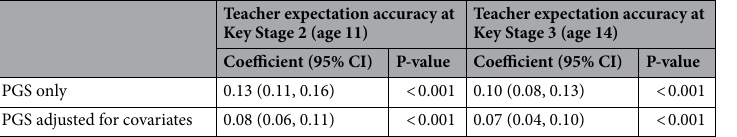
Table 3. Associations between teacher expectation and pupil’s polygenic scores (PGS). Positive values reflect pupils who overperformed relative to their teacher’s expectations, while negative values reflect pupils who underperformed relative to their teacher’s expectations. n = 7465. Full results in Supplementary Table S2. Results for complete case analyses presented in Supplementary Table S3.